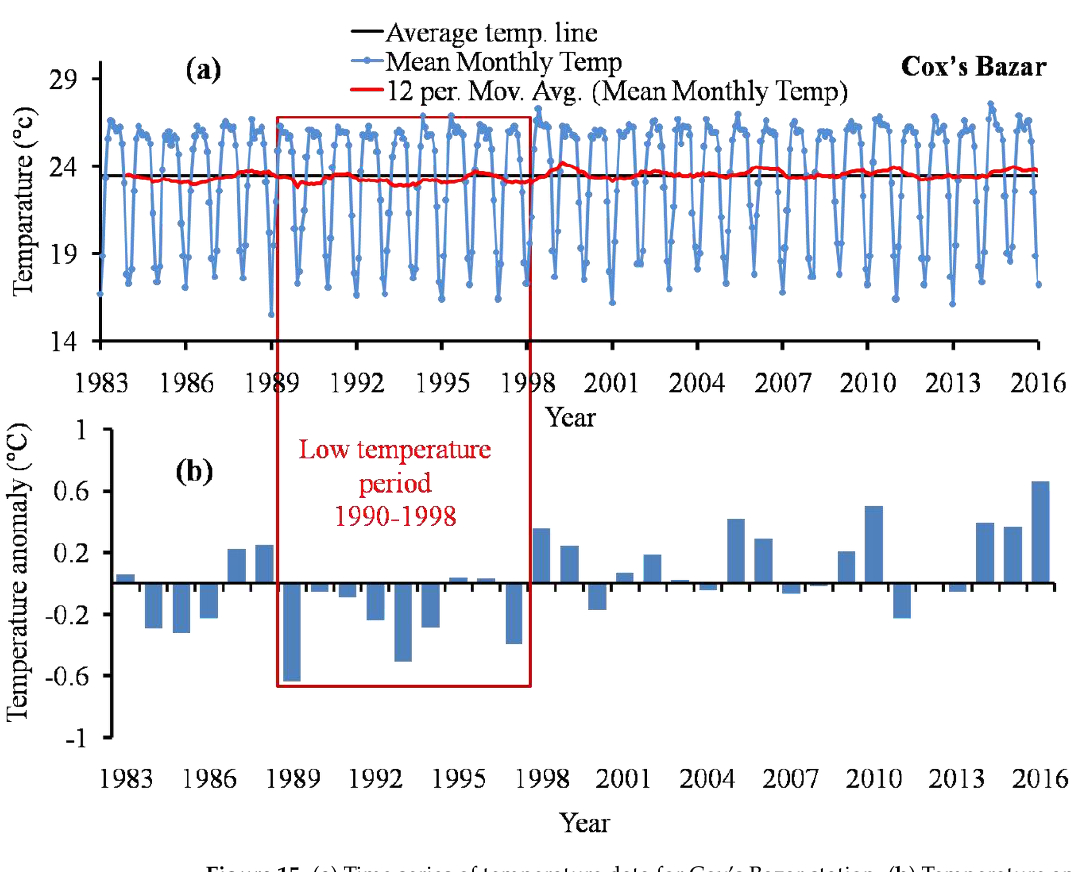
Figure 15. ( a ) Time series of temperature data for Cox’s Bazar station. ( b ) Temperature anomaly from 1983–2016. Anomaly represents the fluctuation of the yearly temperature from the zero mean.